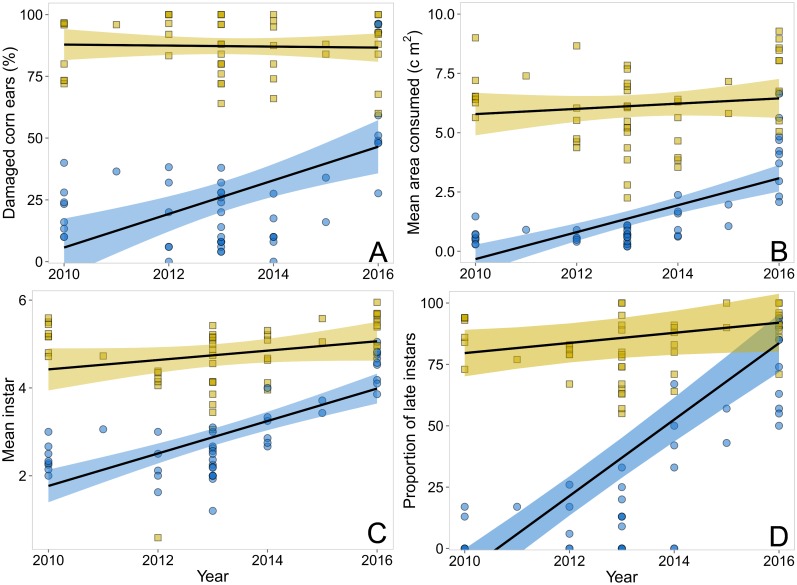
Trends comparing efficacy of Cry1A.105+Cry2Ab2 Bt sweet corn (Performance Series) with non-Bt isogenic hybrids for control of Helicoverpa zea during 2010–2016 in Maryland, USA.Over years, Bt hybrids (blue circles and shades) had significant increases in the percentage of H. zea damaged ears (A), kernel consumption (B), instar stage (C) and proportion of late instars (D) than non-Bt hybrids (yellow squares and shades). Points represent the raw data, black lines represent the predictions from LMMs / GLMM, while shaded region denote the upper and lower confidence levels (95% CI).